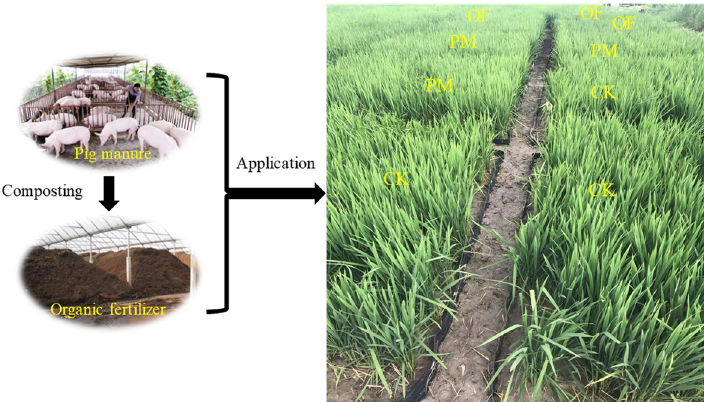
Figure 1. Site layout (CK-controlled group, PM-pig manure, OF-organic fertilizer)